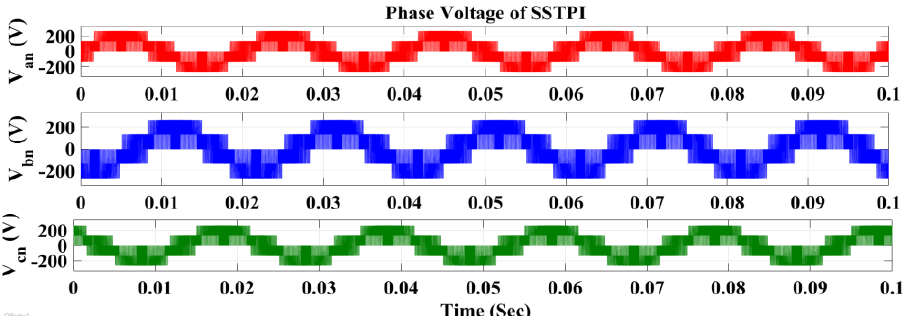
Figure 12. Output phase voltages of SSTPI